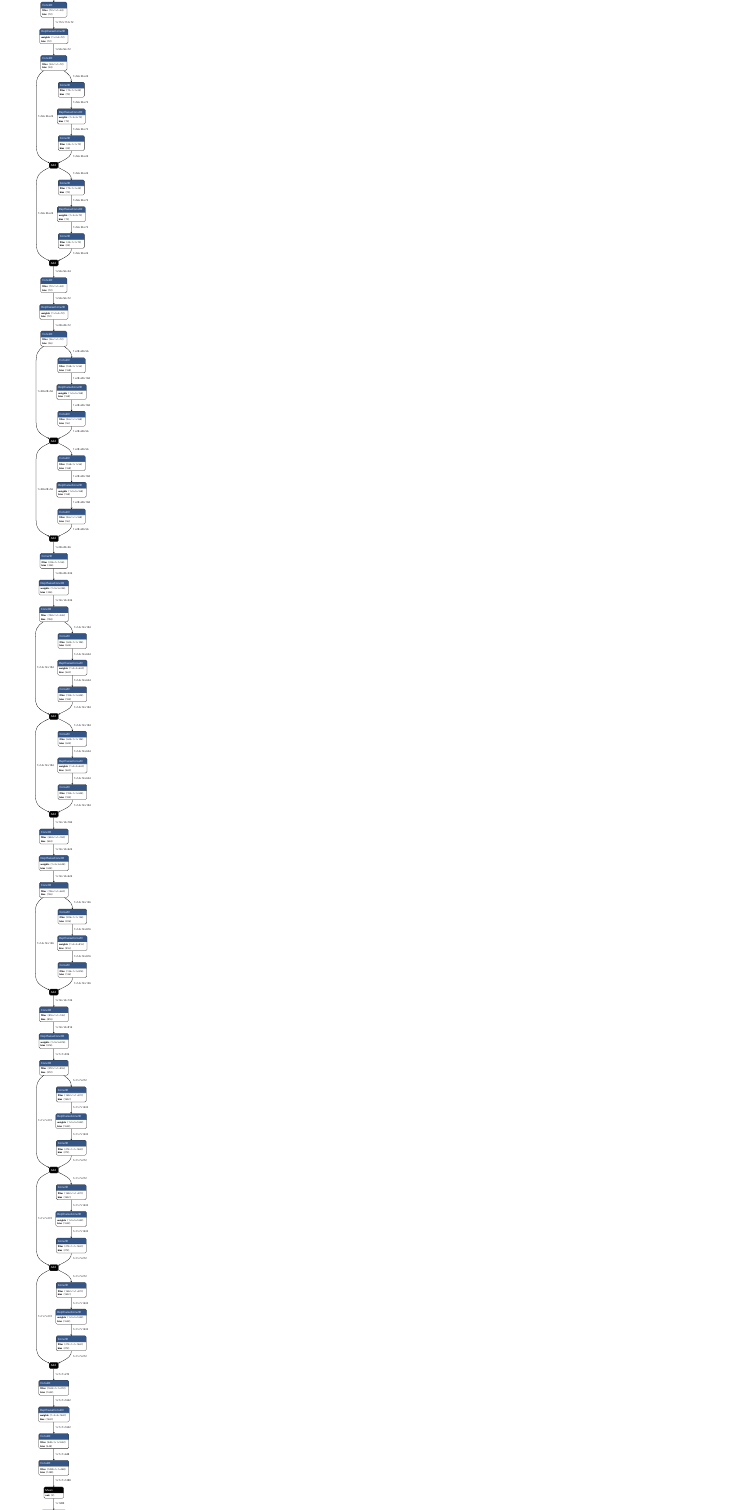
Figure A2. Structure of the convolutional neural network (CNN) used for Varroa destructor